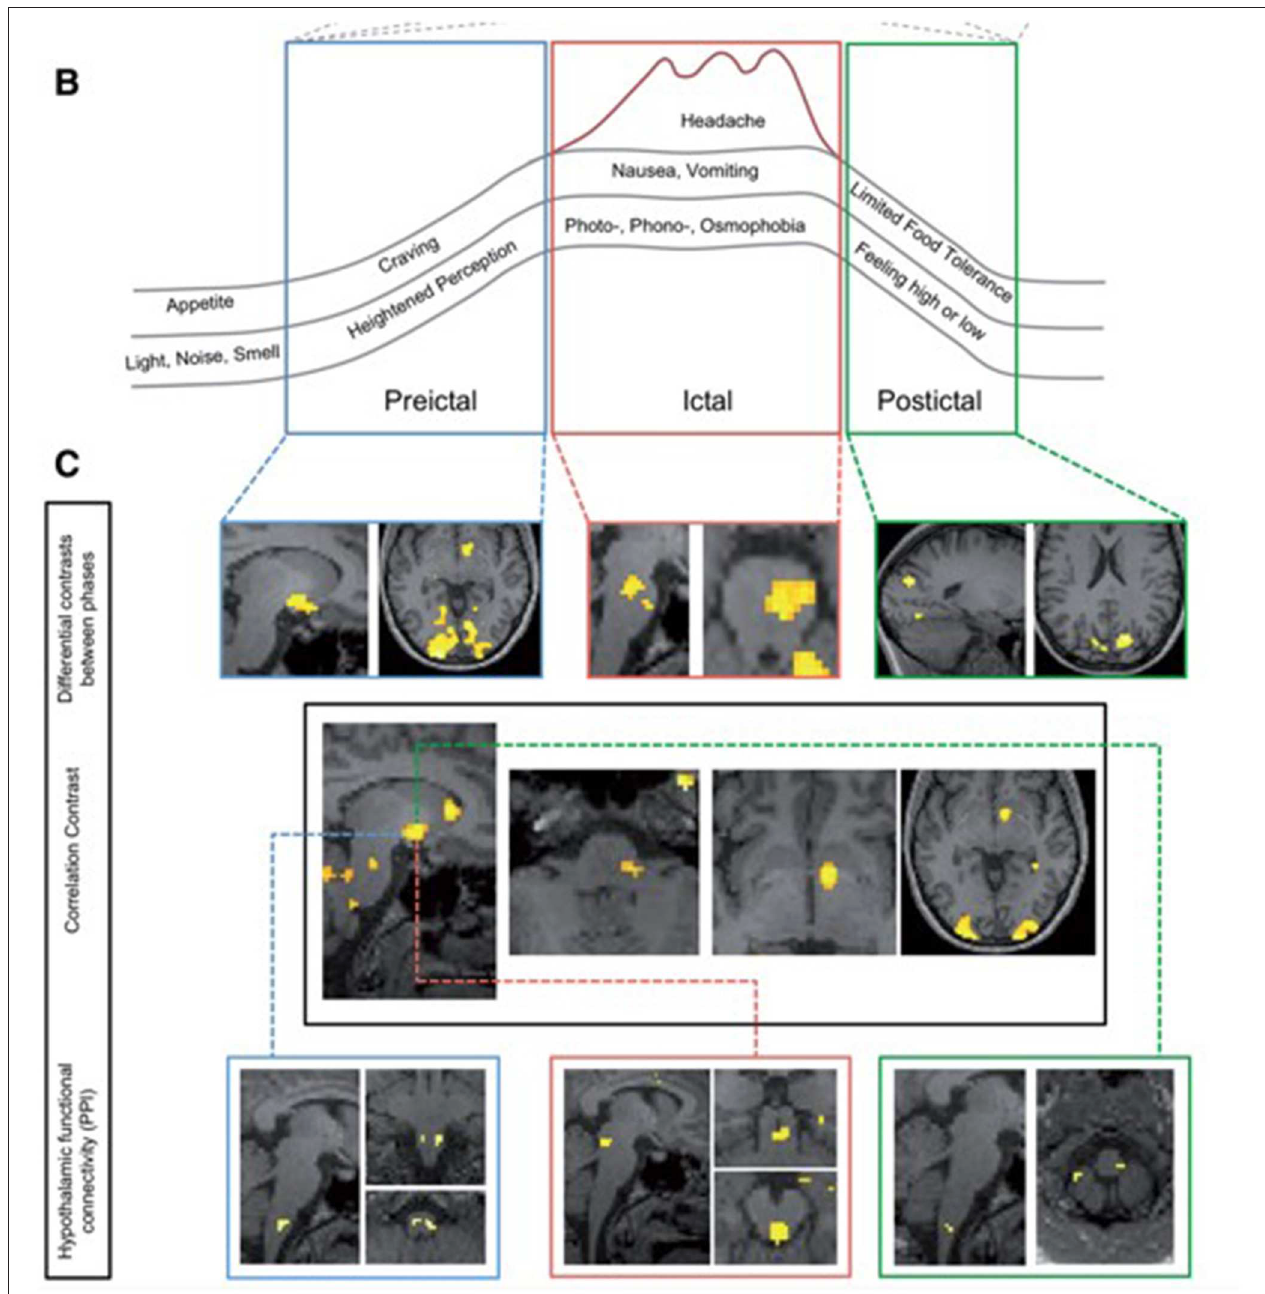
FIGURE 2 | Changes during the migraine cycle, taken from the Schulte et al. study (37). (A) Unpleasantness ratings for ammonia, rose odor, and checkerboard stimulation (red line and dots: ammonia-ratings; green line and crosses: rose odor ratings; blue line and asterisks: checkerboard ratings), with higher values representing a more unpleasant experience. Red areas: days of migraine pain with varying red color intensities indicating different intensities of migraine pain and blue areas representing the last scan before onset of migraine pain. (B) Overview of the migraine cycle. (C) Results from functional MRI.